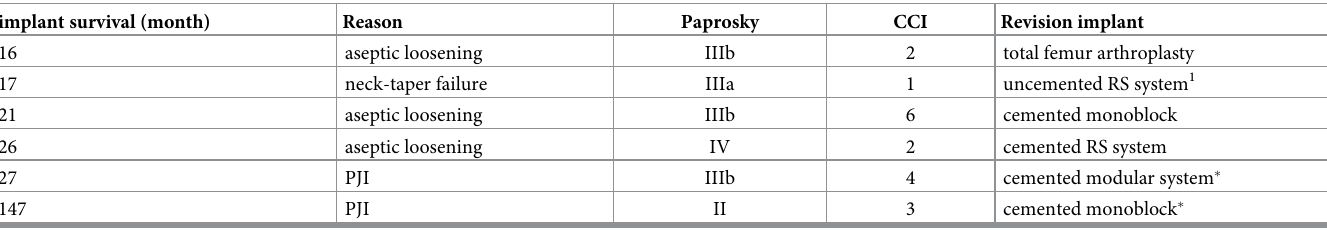
Table 3. Patients with stem